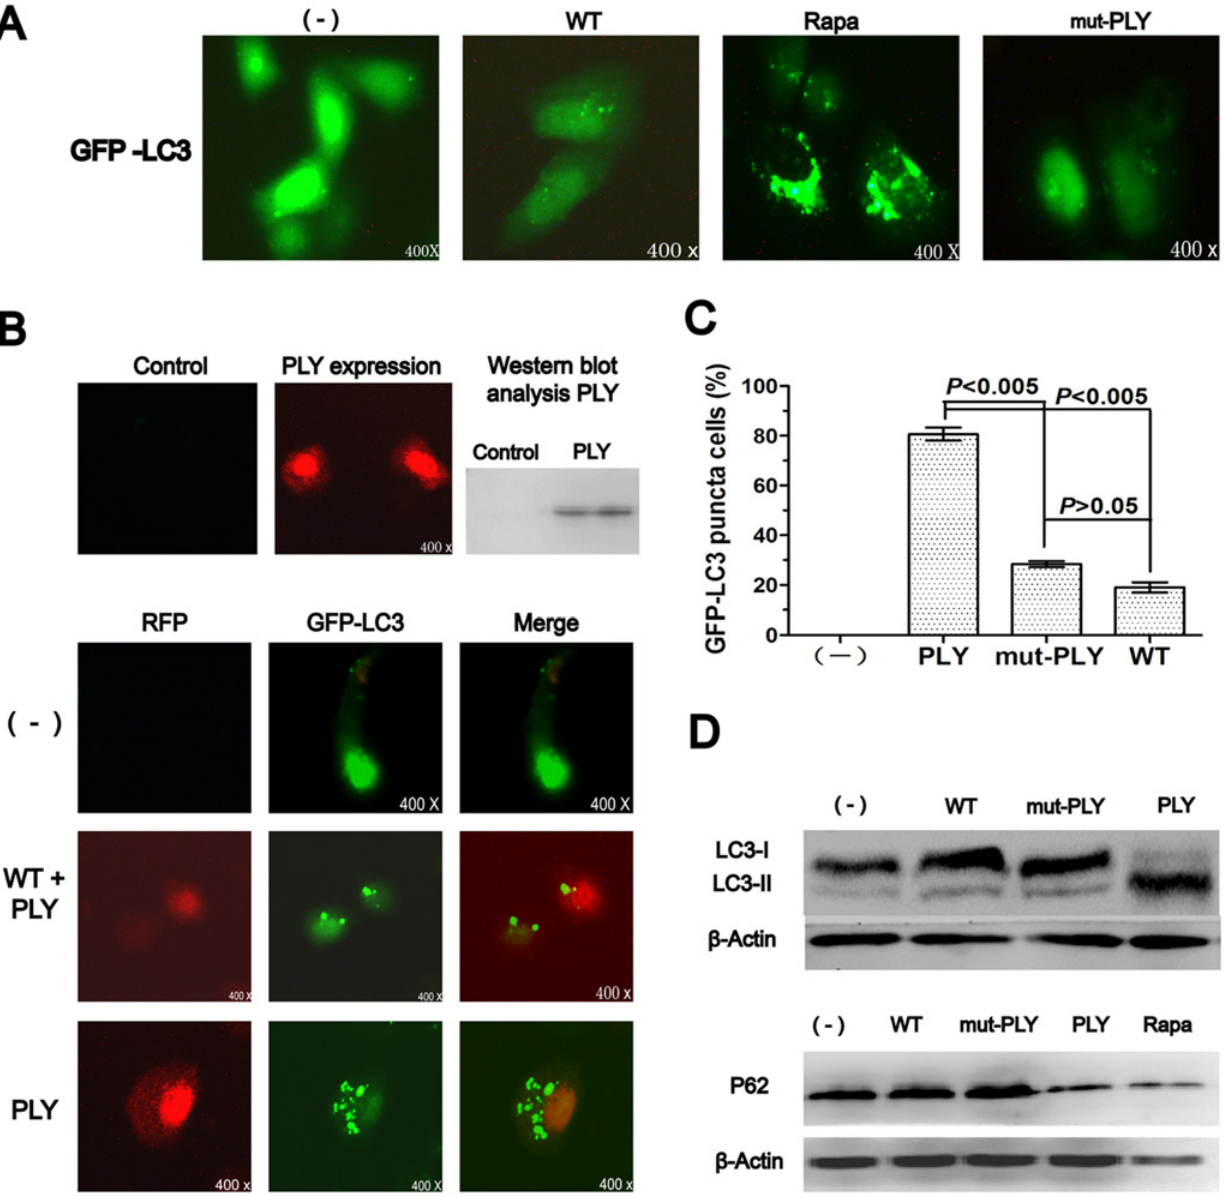
Fig 3. Pneumococcal PLY is involved in initiating autophagy. A549 cells were infected with Sp or mut-PLY for 1 h (MOI=30:1). Before infection, the cells were also treated with rapamycin (1 mM, 10 h) and wortmannin (2 μ M, 2 h). (A) mut-PLY failed to induce LC3 punctation. (B) RFP-PLY induced LC3 punctation in cotransfected cells. (C) The puncta in each cell were counted and cells with more than 10 punctae were considered GFP-LC3 puncta cells. Values are from 100 cells/sample (one-way ANOVA; Tukey ’ s posthoc test). (D) Western blotting of LC3 and p62. Data are representative of three experiments with similar results; Rapa: rapamycin; WT: wortmannin; p62: Sequestosome 1; PLY: pneumolysin; mut-PLY: PLY-deficient